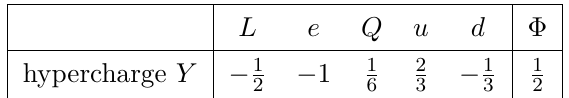
Table 3. Hypercharges for the SM fermions and Higgs